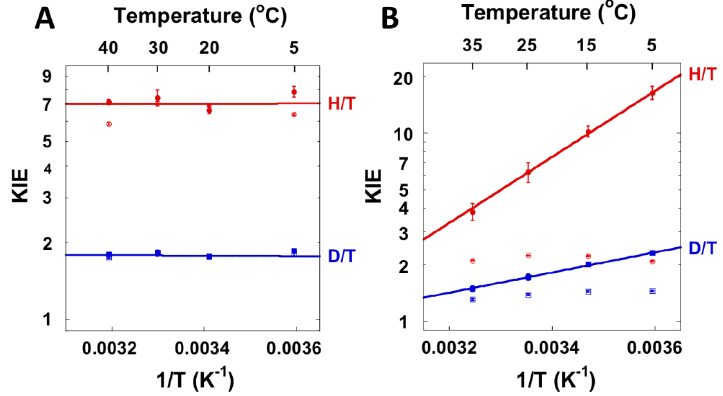
Figure 5. 1° KIEs on the hydride transfer ( A ) and the proton transfer ( B ) catalyzed by wt E. Coli TSase. The empty and filled points are the observed and intrinsic KIEs, respectively. Reproduced with permission from ref.